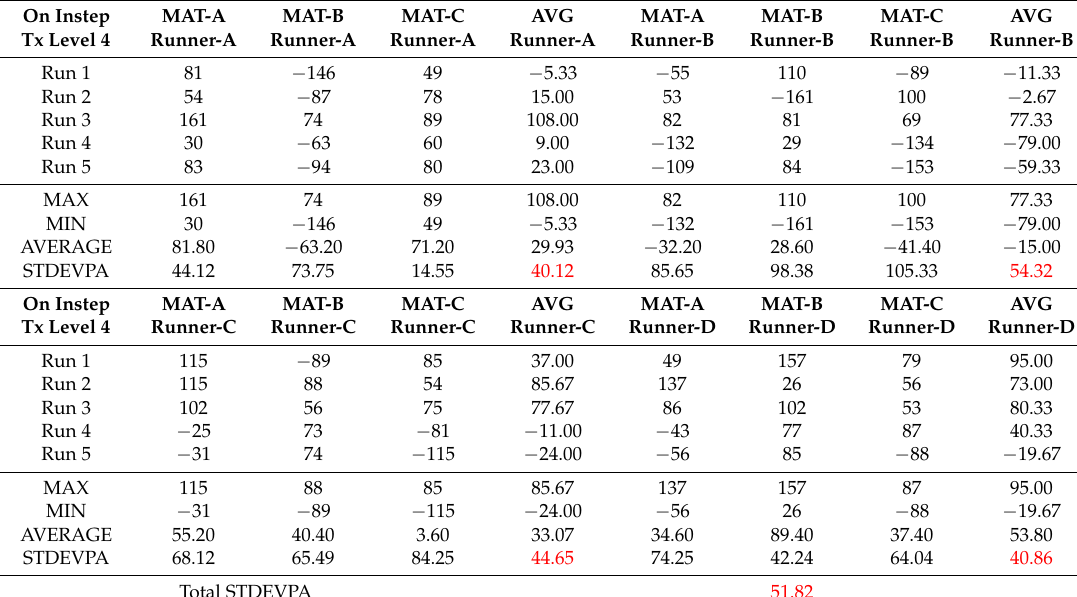
Figure 19. Four runners with a BLE Tag on their respective insteps ran through the three sets of MAT one by one. Table 17. The experiment in which four runners with a BLE Tag on their respective chests ran through three sets of MAT.